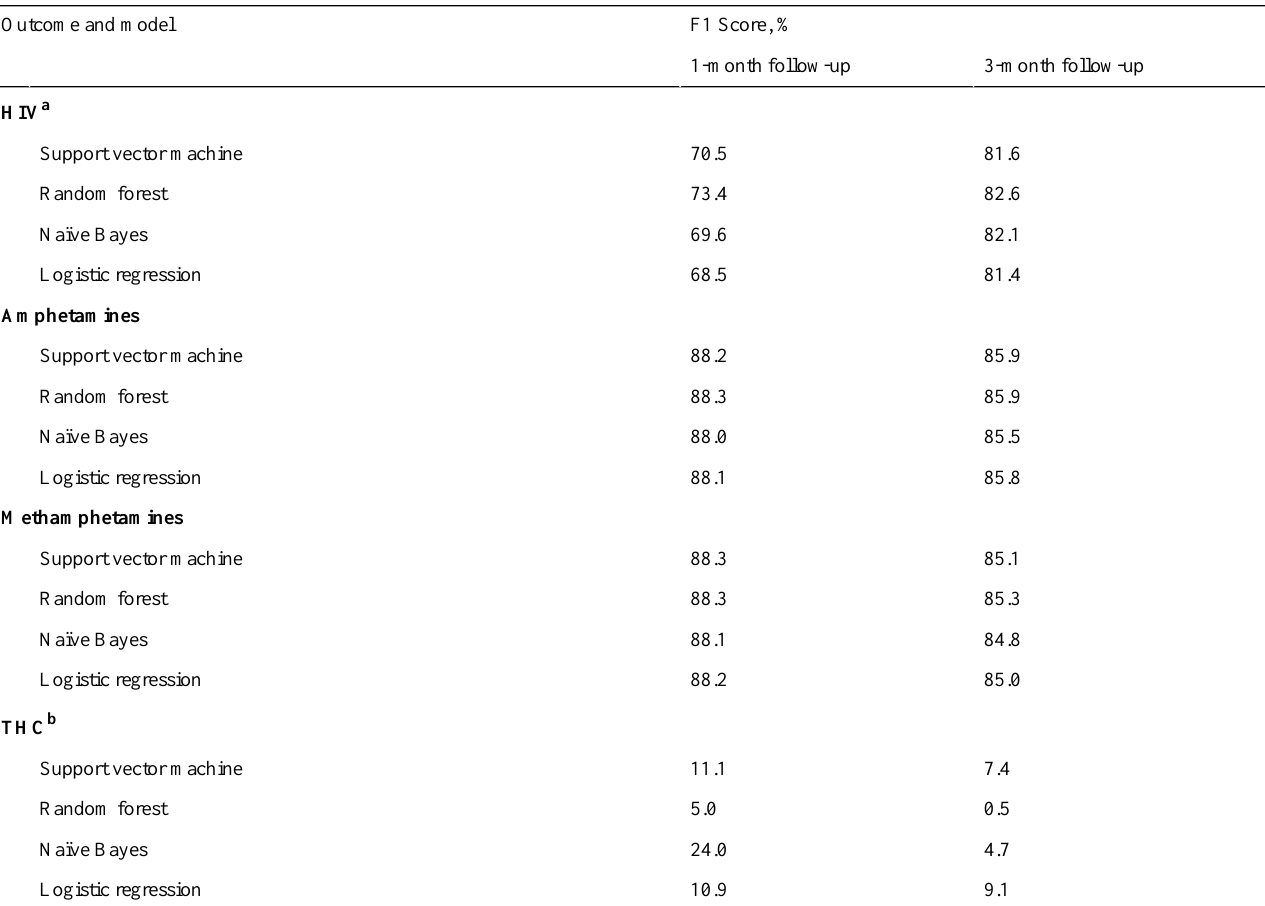
Table 4. F1 scores for each respective model and outcome in a 1-month and 3-month follow-up period after participants’initial onboarding.